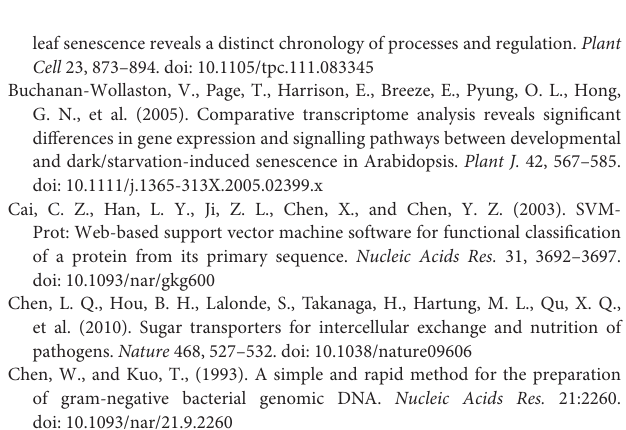
Supplementary Figure 1 | Expression profiles of the senescence-related genes are detected in various oss40 mutants by RT-qPCR. Supplementary Figure 2 | Subcellular localization of OsWRKY79 in rice protoplast. Supplementary Figure 3 | Expression profiles of OsS40 genes are detected in various oss40 mutants by RT-qPCR. Supplementary Dataset 1 | Expression profiles of the OsS40 family during rice flag leaf